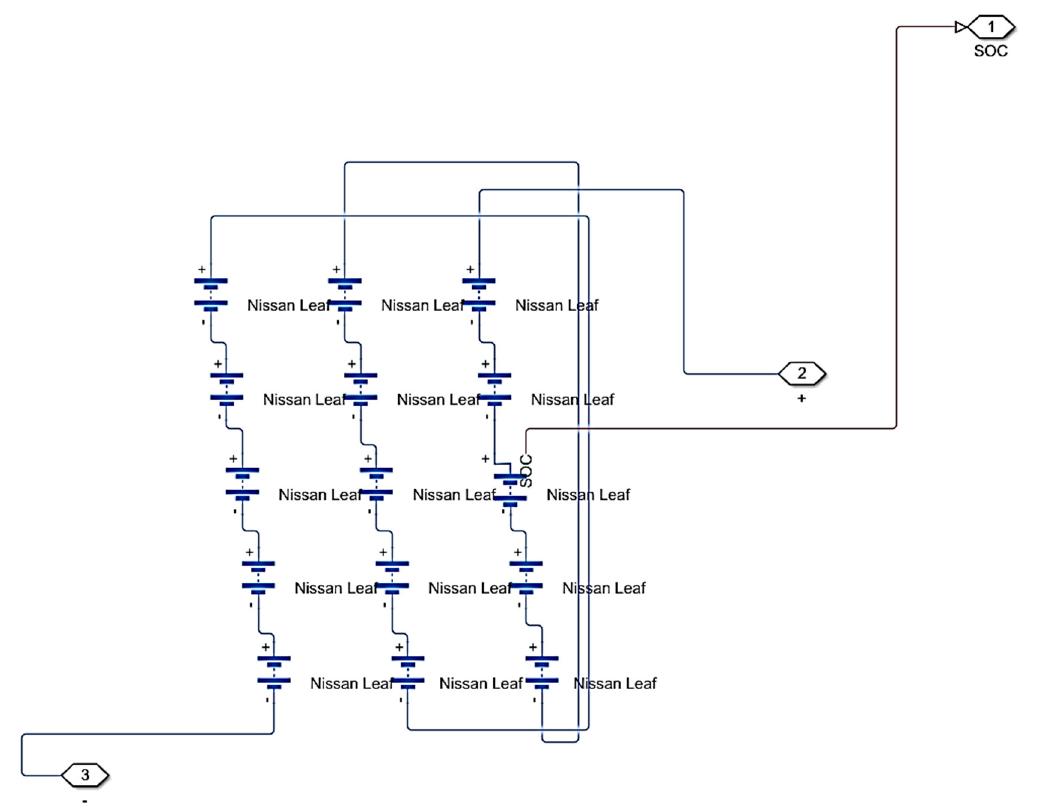
Figure 4. Block diagram of the 2nd life Nissan Leaf battery pack in MATLAB SIMULINK. Table 1. The defined scenarios in this study.